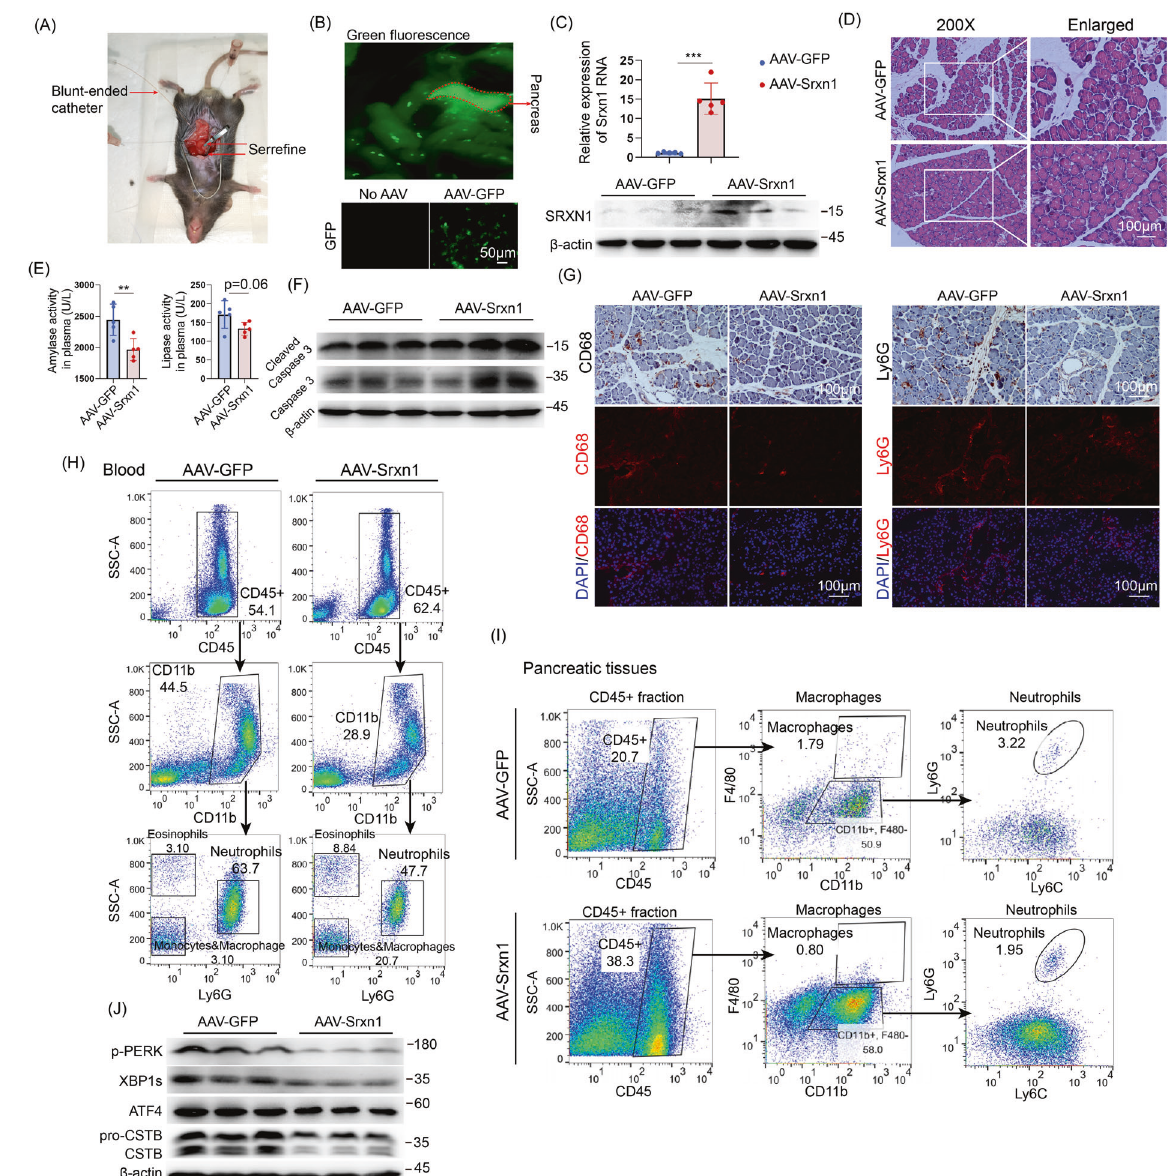
Fig. 6 AAV-mediated overexpression of Srxn1 protects against AP. A Schematic of the microinfusion system for intraductal administration of AAV. B Fluorescence imaging of pancreas (upper) and pancreatic sections (lower) after AAV administration for 14 days. C SRXN1 RNA and protein was upregulated by AAV-Srxn1 in pancreatic tissues. D AAV-Srxn1 markedly reduced amylase and lipase activity in plasma compared with control. F Cleaved caspase 3 was decreased in AAV-Srxn1 group. G IHC and IF staining of CD68 and Ly6G showed a reduced in fi ltration of M1 macrophages and neutrophils by AAV-Srxn1 in pancreas. H Flow cytometry analysis of blood showed a decrease of neutrophils (CD45 + / CD11b + /Ly6G + ) in AAV-Srxn1 group. I Flow cytometry analysis of pancreatic tissues showed a decrease of in fi ltrating neutrophils (CD45 +